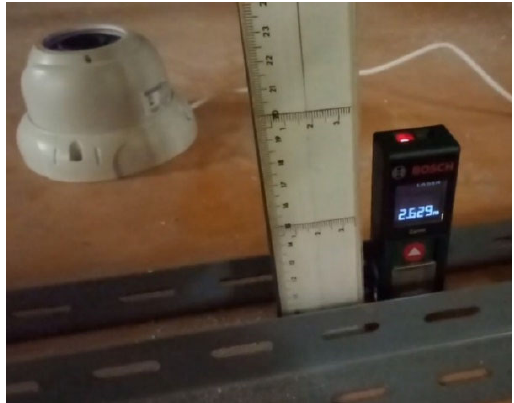
Figure 10. Overview of the measurement system which was used.